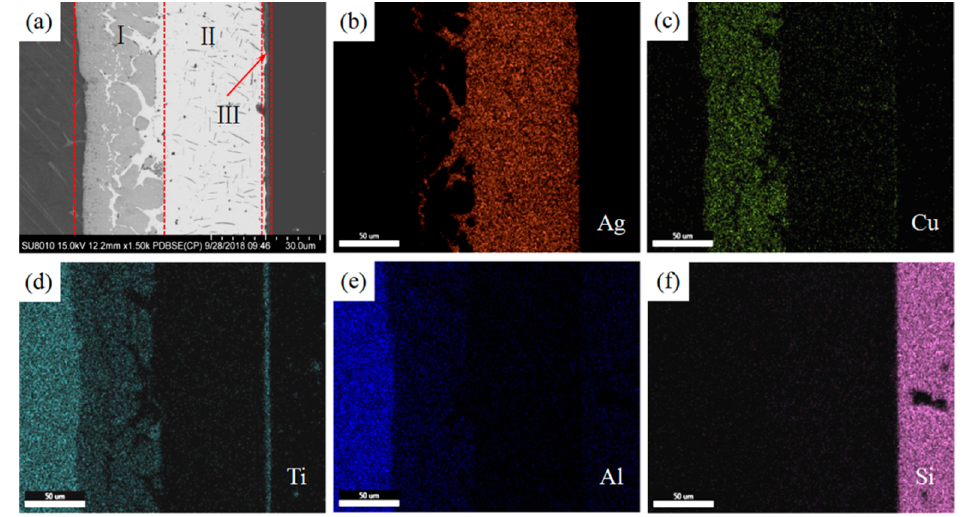
Figure 2. Elemental analysis results of the TiAl/AgCu/Si 3 N 4 joints brazed at 1173 K. ( a ) Interfacial microstructure; ( b – f ) element distribution images of Ag, Cu, Ti, Al and Si